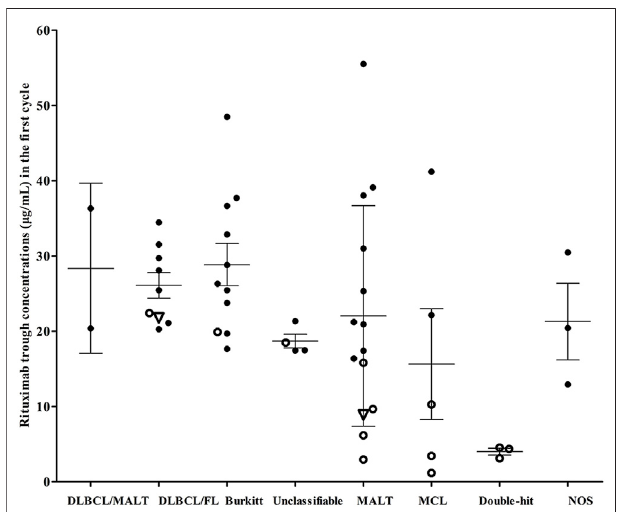
FIGURE 2 | Rituximab concentrations and clinical outcomes of patients with different lymphoma subtypes. Hollow dots, patients who failed fi rst-line treatment; hollow triangles, patients who relapsed after achieving a complete response. DLBCL, diffuse large B-cell lymphoma; FL, follicular lymphoma; Unclassi fi able, unclassi fi able B-cell lymphoma (intermediate between DLBCL and classical Hodgkin ’ s); MALT, marginal zone lymphoma; MCL, mantle cell lymphoma; “ Double-hit ” , High-grade B-cell lymphomas with translocations of MYC and BCL2 and/or BCL6; NOS, high-grade B-cell lymphomas appear blastoid or cases intermediate between DLBCL and Burkitt lymphoma, but which lack an MYC and BCL2 and/or BCL6 rearrangement.